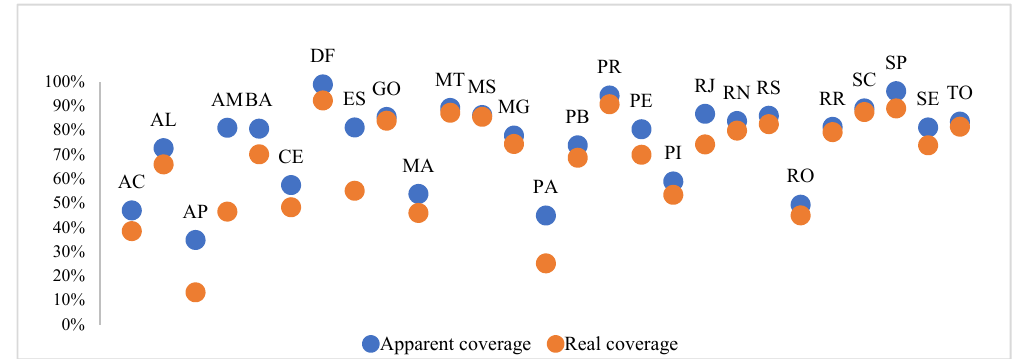
Figure 2. WSS coverage indicators by federation state.